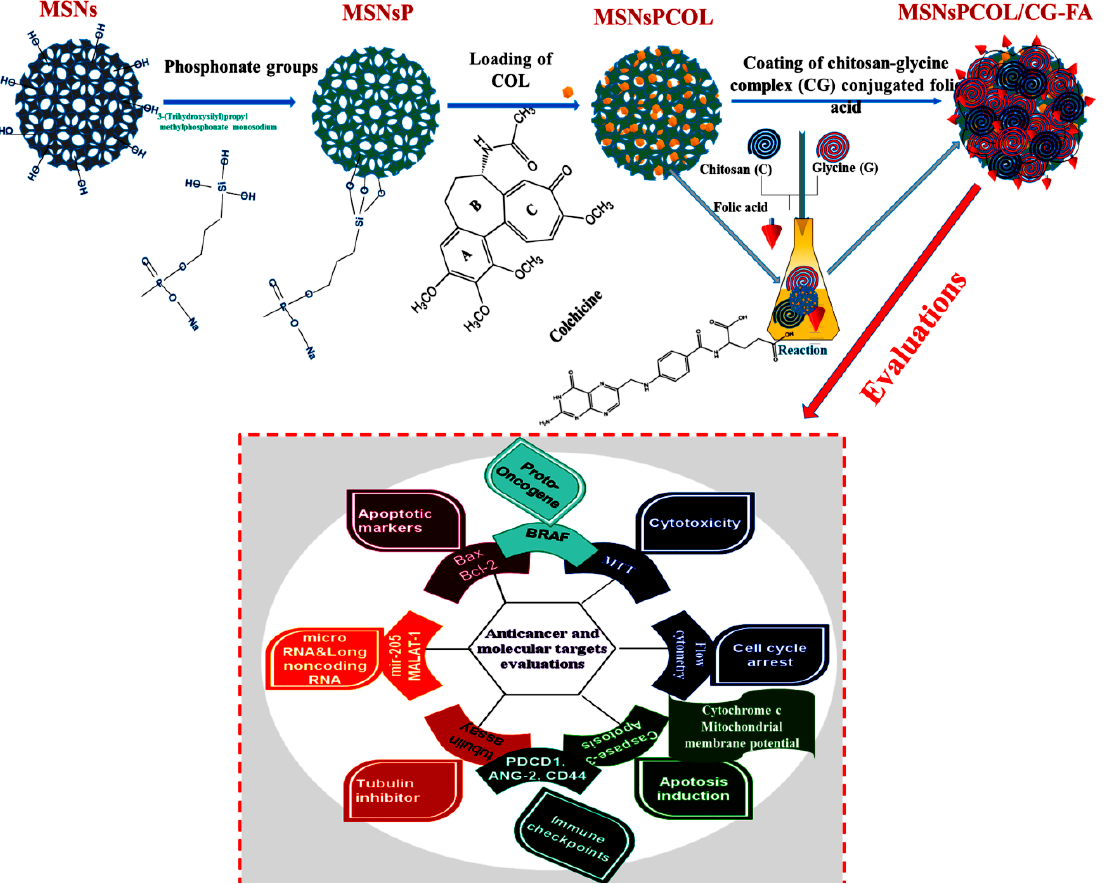
Figure 1. Schematic representation of the steps to obtain the proposed drug delivery system with the final product (MSNsPCOL/CG-FA) and various biological evaluations in vitro. final product (MSNsPCOL / CG-FA) and various biological evaluations in